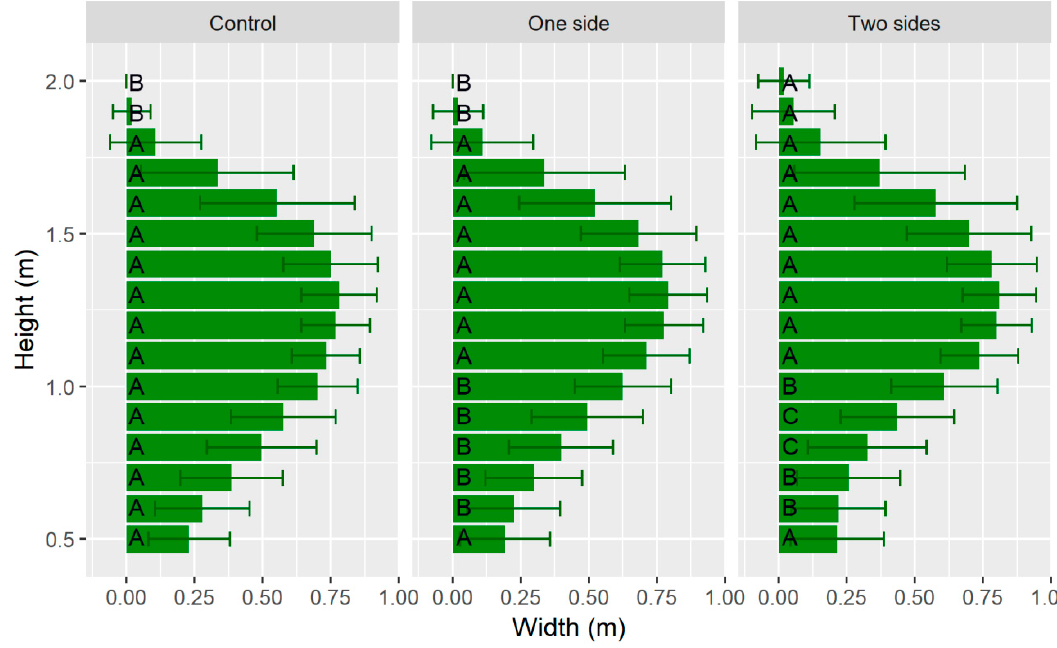
Figure 8. Vine width at different heights after the leaf removal experiment at Traibuenas (error bars represent the standard deviation). For each height, different letters indicate significant differences among treatments at p = 0.05 by a Student’s T-test.